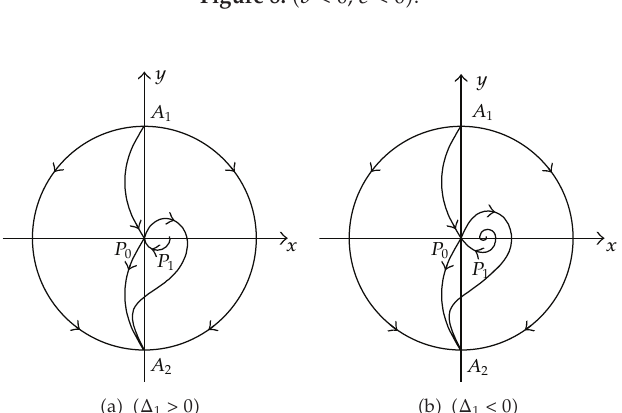
Figure 8: (cid:6) b < 0, c < 0 (cid:7) .